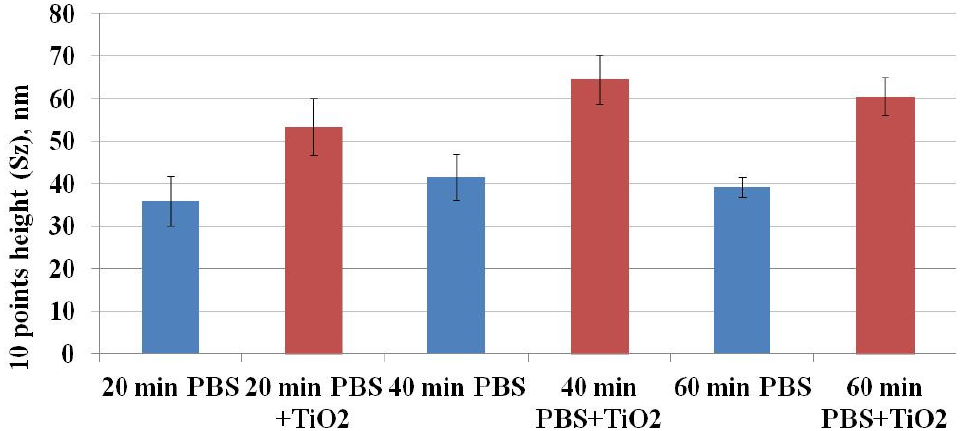
Figure 8. The dependence of the 10-point height ( S z) surface roughness factor on the exposure time